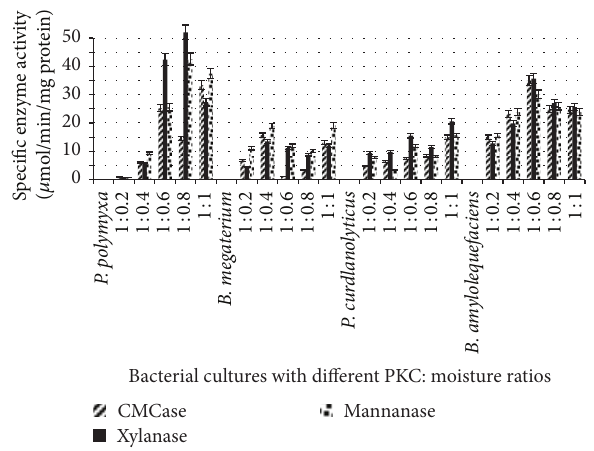
Figure 4: Specific enzyme activity for some bacterial cultures under SSF with different PKC:moisture